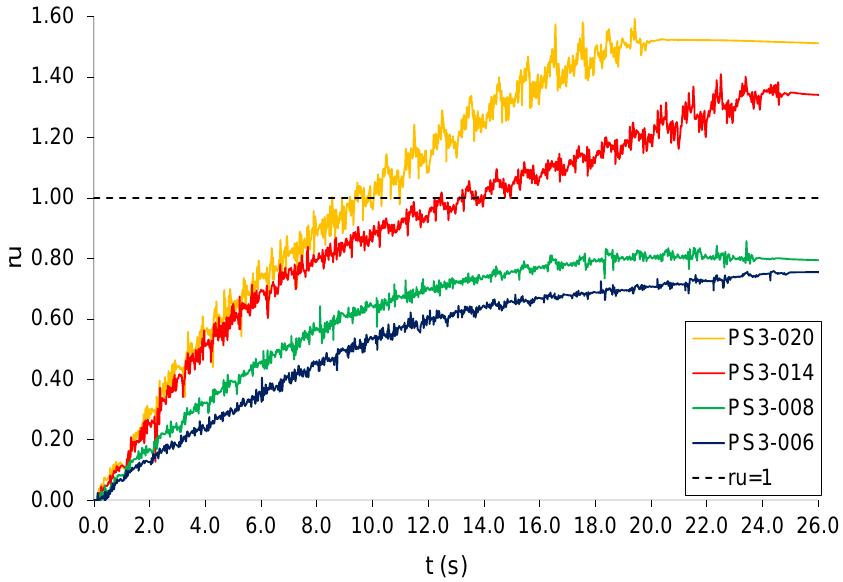
Figure 10. Pore pressure ratios versus time for parametric study PS3.